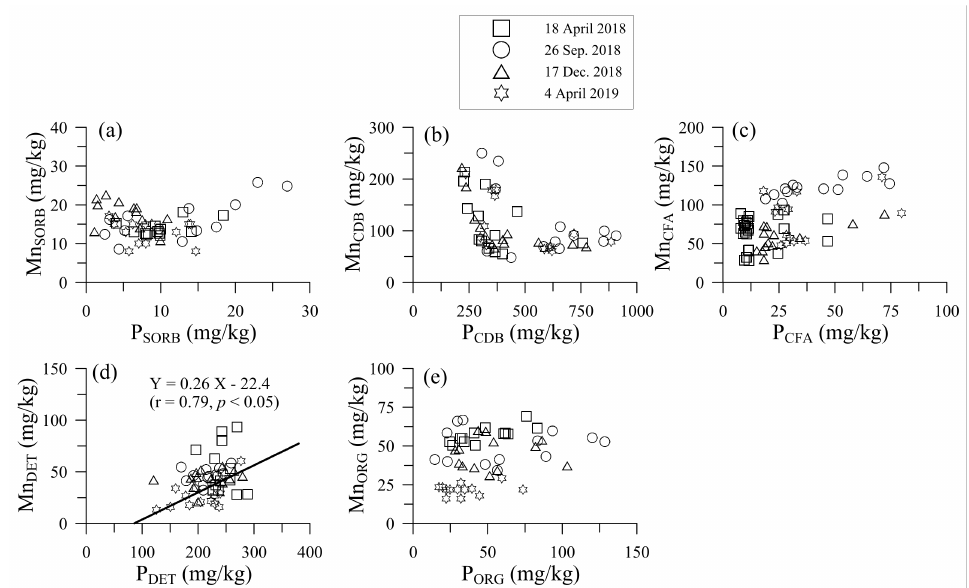
Figure 12. Scatter plots of the five fractions P and Mn concentrations in the DRE surface sediments ( a ) P SORB against Mn SORB , ( b ) P CDB against Mn CDB , ( c ) P CFA against Mn CFA , ( d ) P DET against Mn DET , and ( e ) P ORG against Mn ORG